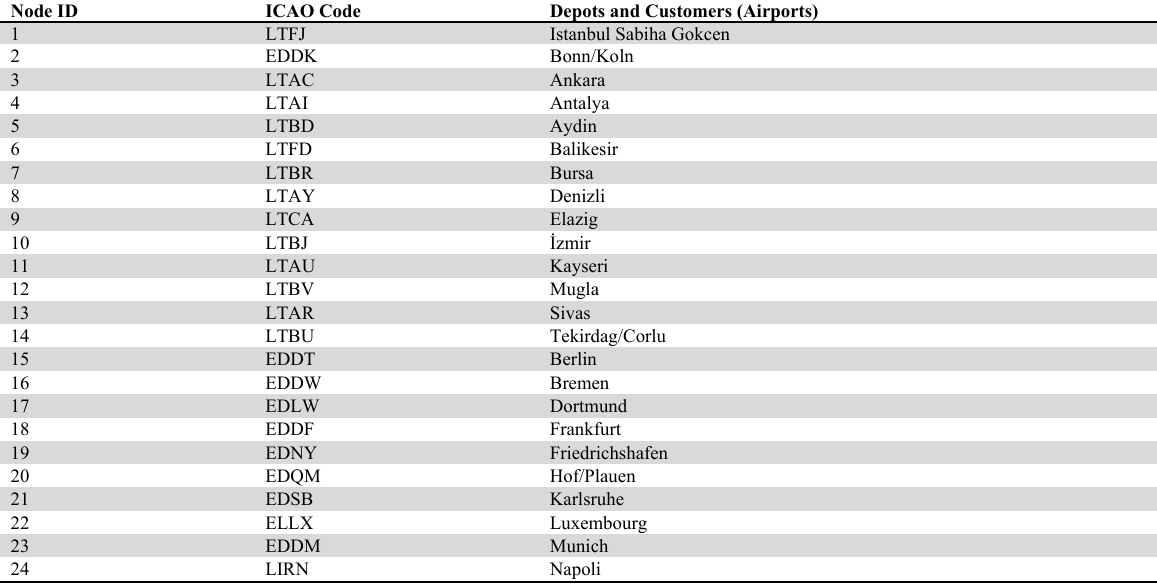
Depot and customer nodes.